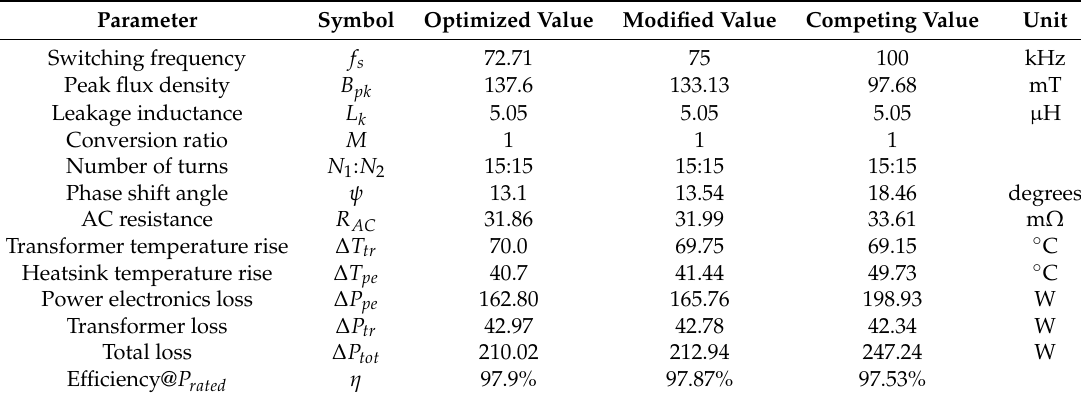
Table 3. Optimal and modified